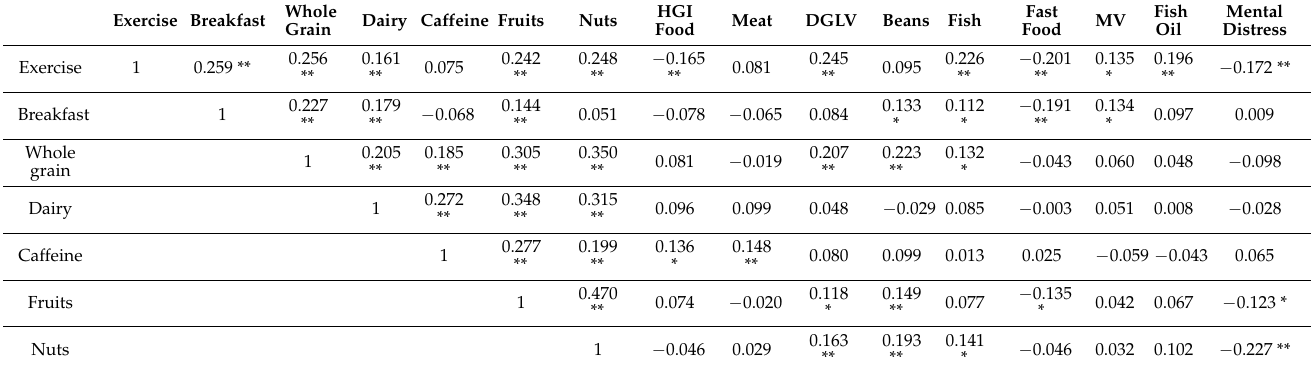
Table 6. Spearman’s rank–order correlation results for mature